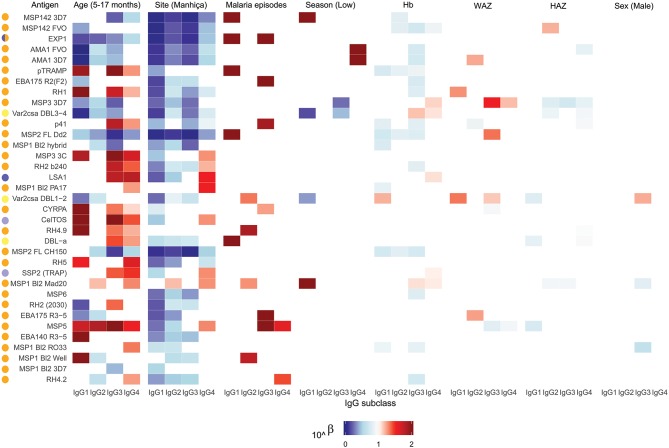
Heatmap of multivariable analysis of the effect of RTS,S/AS01E vaccination and demographic, clinical, and epidemiological variables on IgG subclass levels to Plasmodium falciparum pre-erythrocytic and blood stage antigens at baseline. Linear regression was performed with antibody levels (log10MFI) as outcome and other covariates adjusted (in parenthesis the reference category). Color coded cells show the 10∧Beta of each predictor (columns) for each model (rows). Only results with a significant (<0.05) p-value are shown. Antigen colors show the P. falciparum life cycle stage in which they are expressed: Pre-erythrocytic (PE) antigens from sporozoite stage (light purple), PE from liver stage (dark purple), blood stage (BS) antigens from merozoite stage (orange), BS from trophozoite stage (yellow).